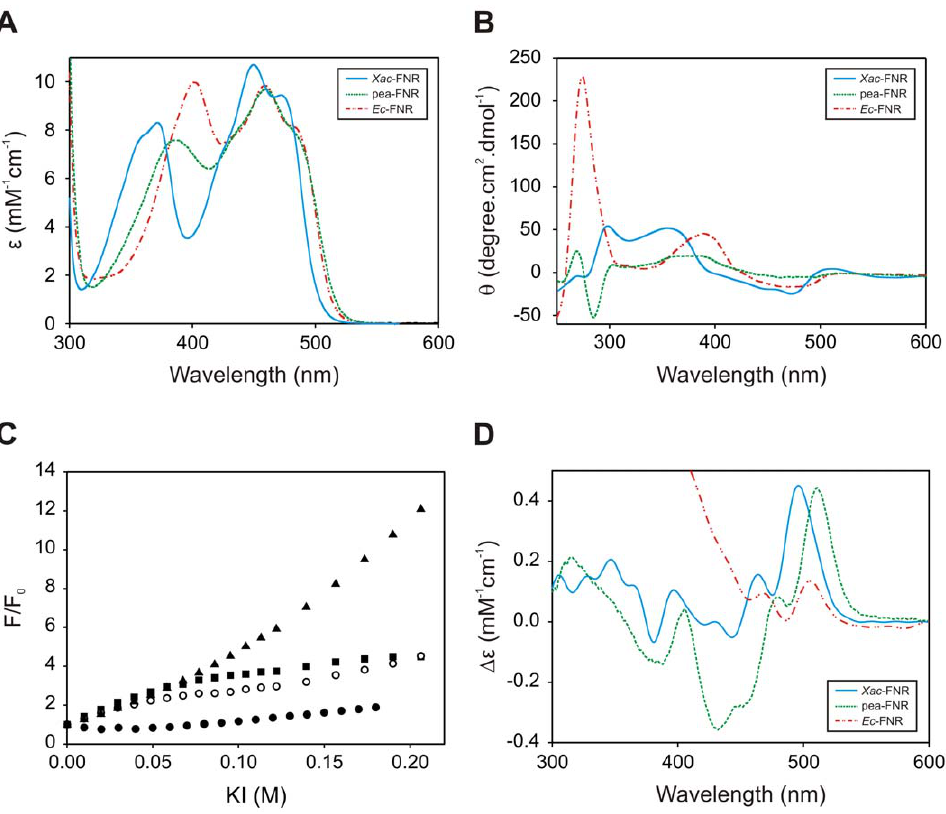
Figure 4. Spectroscopic analyses of Xac -FNR and comparison with the pea and E.coli enzymes. (A) UV-visible spectra displayed by the N different plant-type FNRs. (B) Near-UV and visible CD spectra of the enzymes. (C) FAD solvent accessibility studied by quenching with KI. Xac -FNR ( # ), ), free FAD ( m ). (D) Differential UV-visible spectra elicited by the interaction between the enzymes and NADP + . The spectra pea-FNR ( & ), Ec -FNR ( were obtained by the subtraction of the spectra of FNR in the presence of 0.3 mM NADP + and the free enzyme. Different colors were employed for each FNR variant: cyan, Xac -FNR; green, pea-FNR; and red, Ec -FNR.